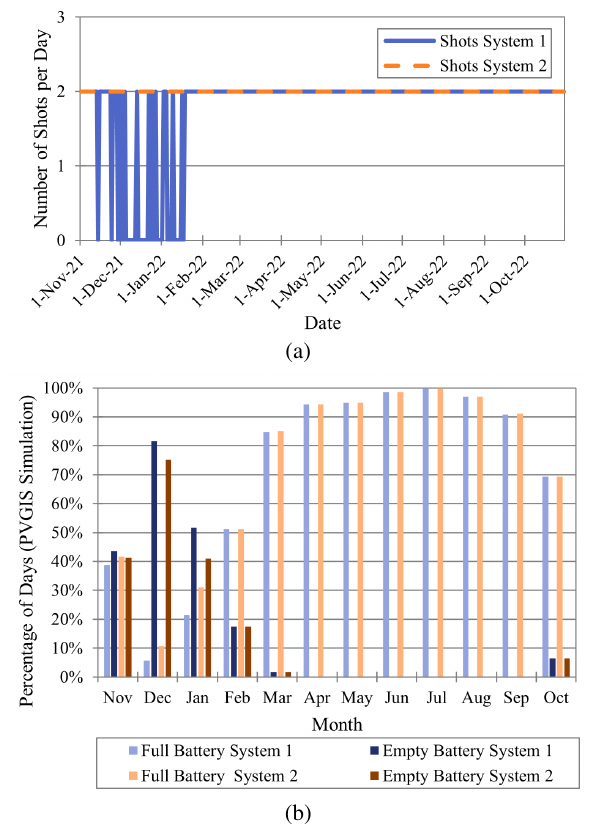
Figure 9. Actual and simulated performances of the system over a year. (a) Number of shots per day of the two systems. (b) Percentage of days in a month when the battery became full or empty according to PVGIS simulations at the location of the two monitoring systems.